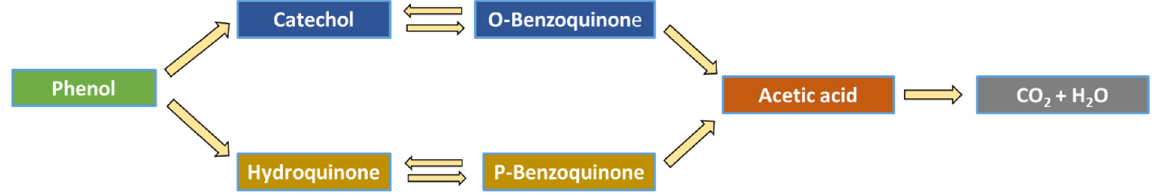
Figure 11. General mechanism of phenol photocatalytic degradation.